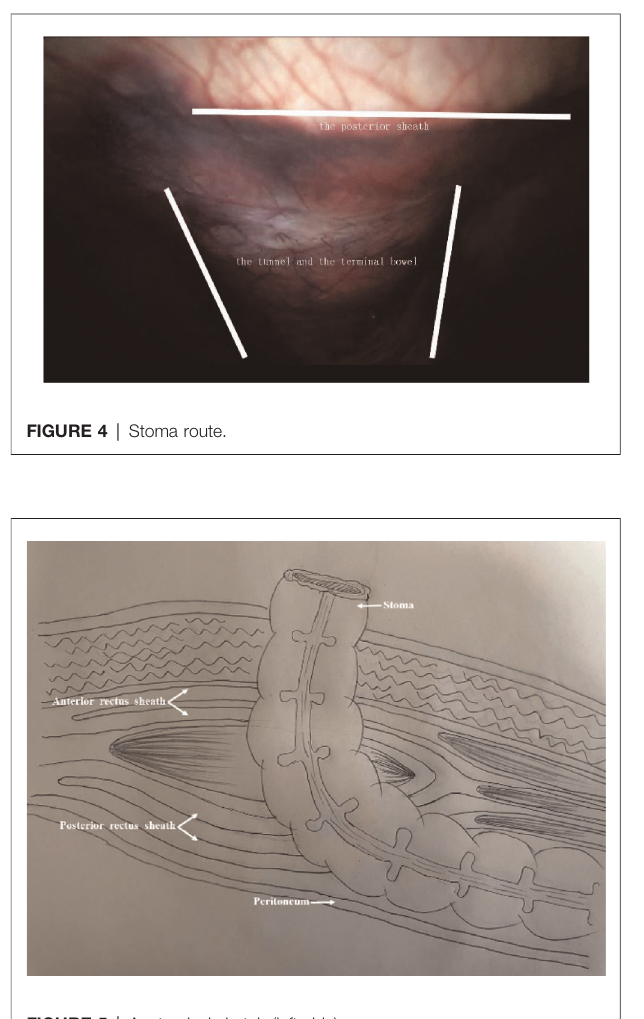
FIGURE 5 | Anatomical sketch (left